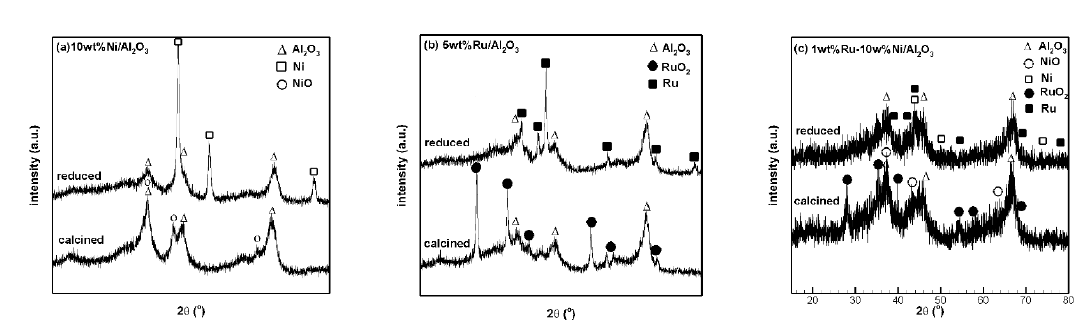
Figure 2. XRD patterns of ( a ) 10 wt% Ni / Al 2 O 3 , ( b ) 5 wt% Ru / Al 2 O 3 , and ( c ) 1 wt% Ru-10 wt% Ni / Al 2 O 3 catalysts.